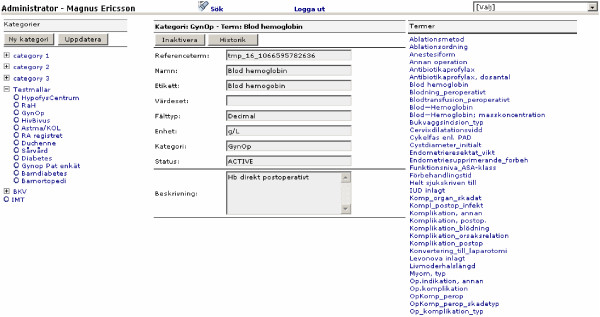
CDS Administration screen.